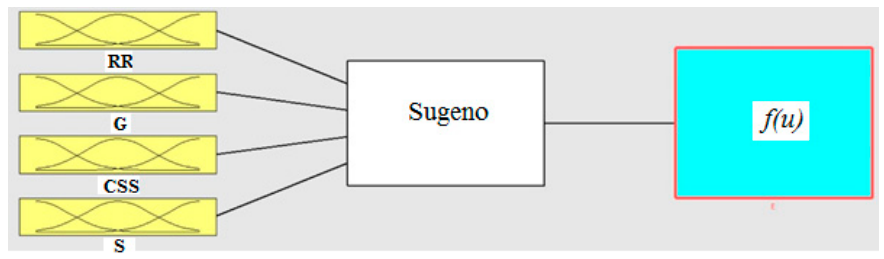
Figure 4. Fuzzy rule architecture of the Gaussian membership function